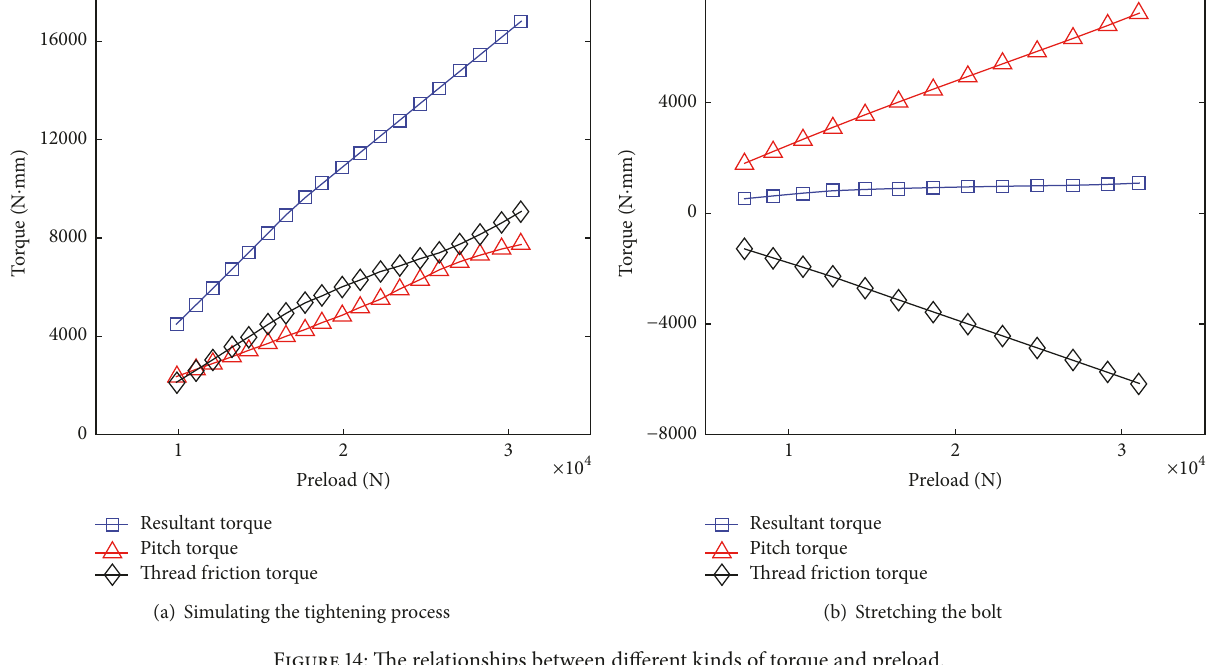
Figure 14: The relationships between different kinds of torque and preload.